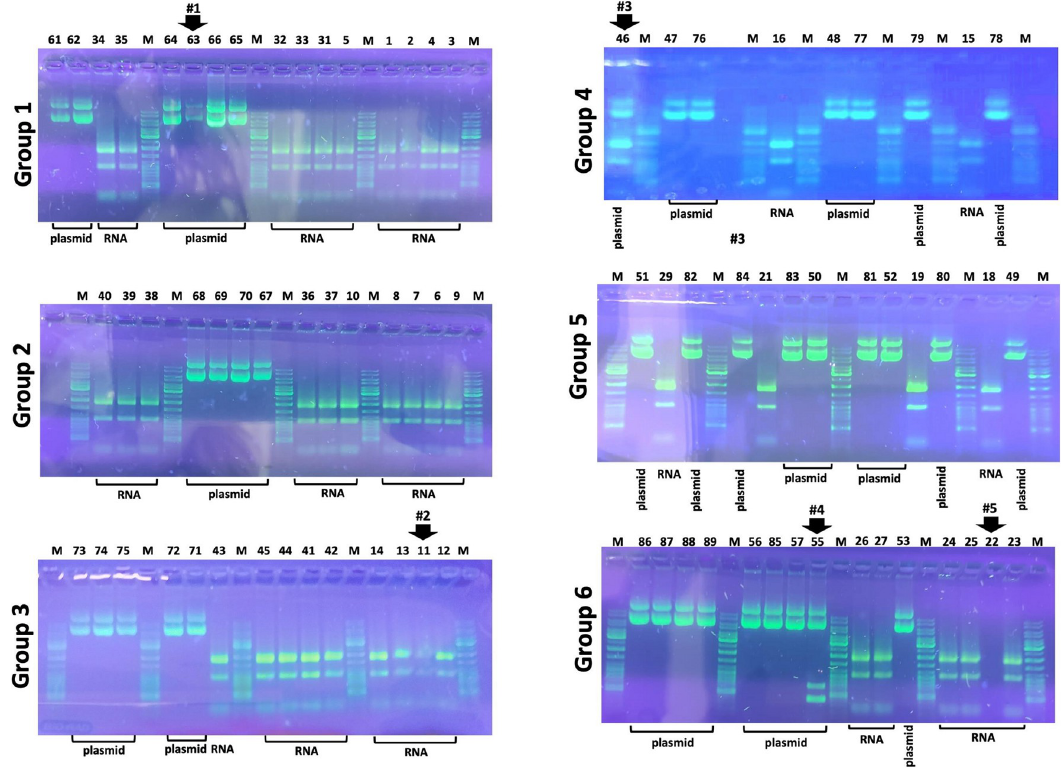
Fig 4. Gel electrophoretic analysis of the pCMV3-GFP-Spike plasmid and the RNA produced by A549 cells. The analysis was conducted by the participating 89 students with excellent results, with the exception of students 63 (Group 1), 11 (Group 3), 46 (Group 4), 22 and 55 (Group 6). The raw uncropped images are included in the S6 File.